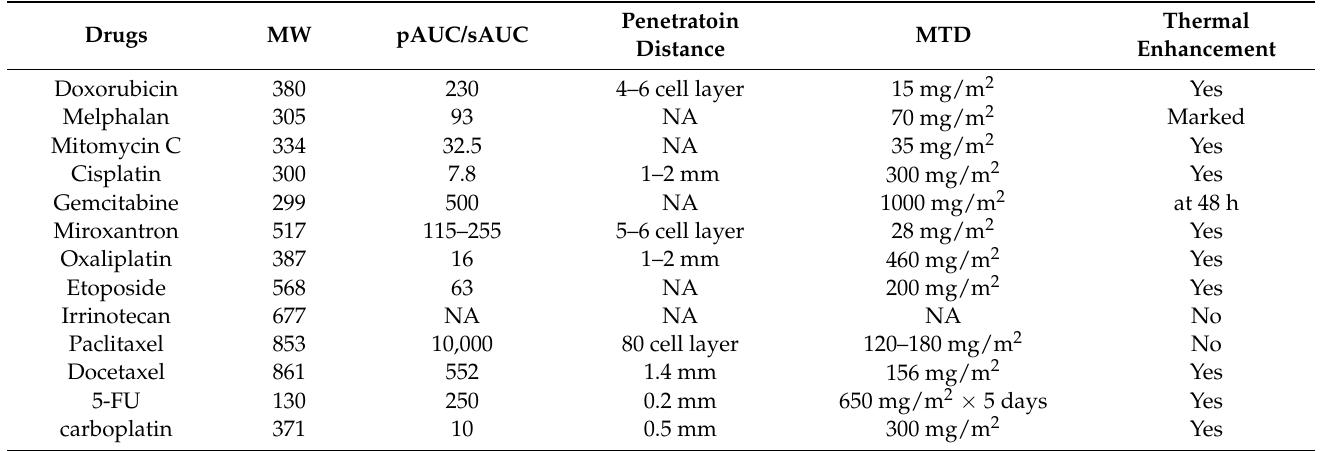
Table 1. Drug molecular weights, pAUC/sAUC, penetration distance into the subperitoneal tissue after intraperitoneal administration, maximum tolerate doses (MTD) and thermal enhancement with each drug. NA: not analyzed, pAUC: area under the curve in peritoneal cavity, sAUC: area under the curve in serum